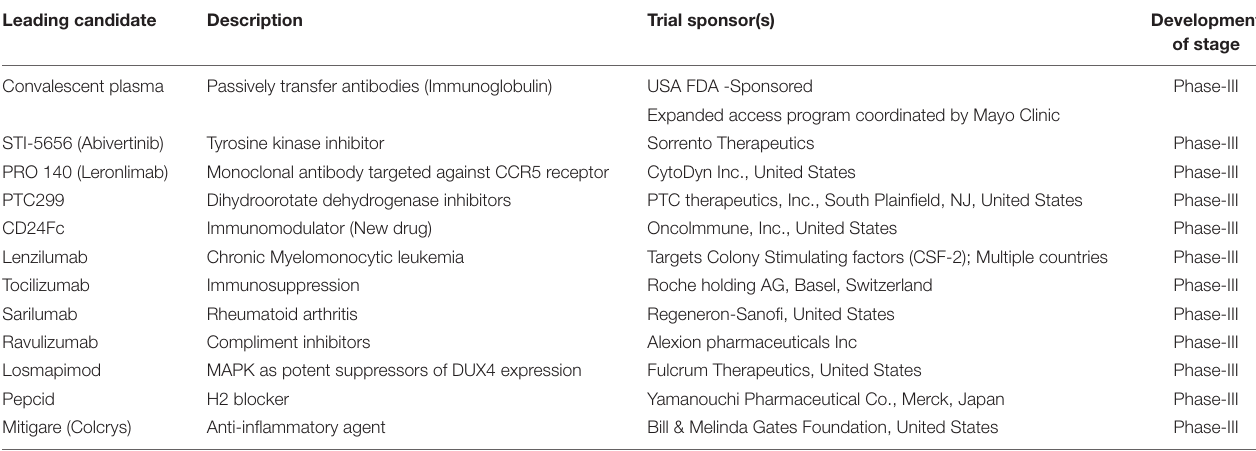
TABLE 3 | Development of SARS-CoV-2 Immunoglobulin based treatments